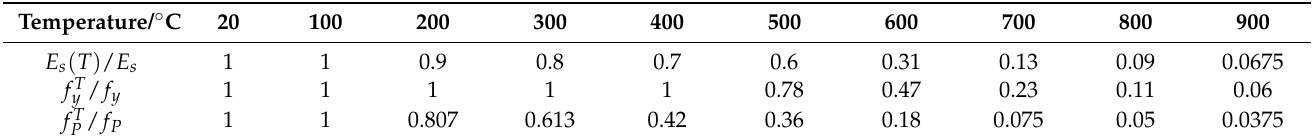
Table 3. The decline rate of steel at high